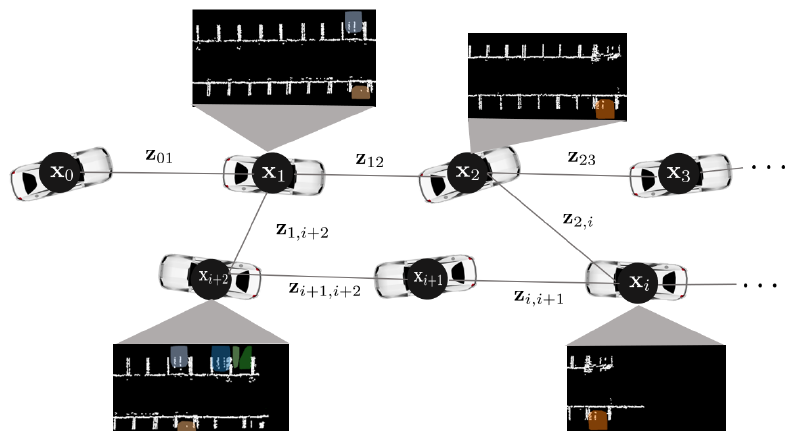
Figure 7. Illustration of pose graph. Each node represents a six degree of freedom (DOF) vehicle pose. The edge is the constraint between two nodes. The temporal edges are generated by LiDAR odometry, and the non-temporal edges are generated by the generalized iterative closest point (GICP) method. All the edges are corrected to compensate for the error that accumulated when the loop closing